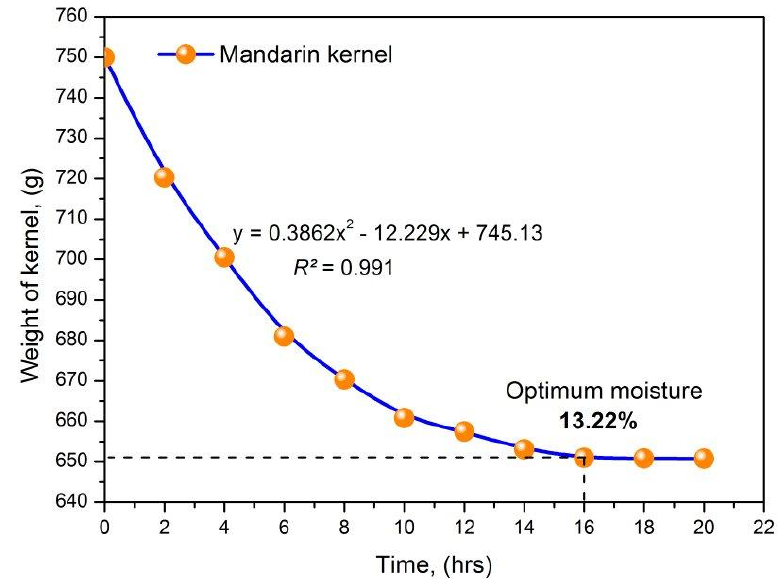
Figure 3. Kernel drying curve for mandarin.